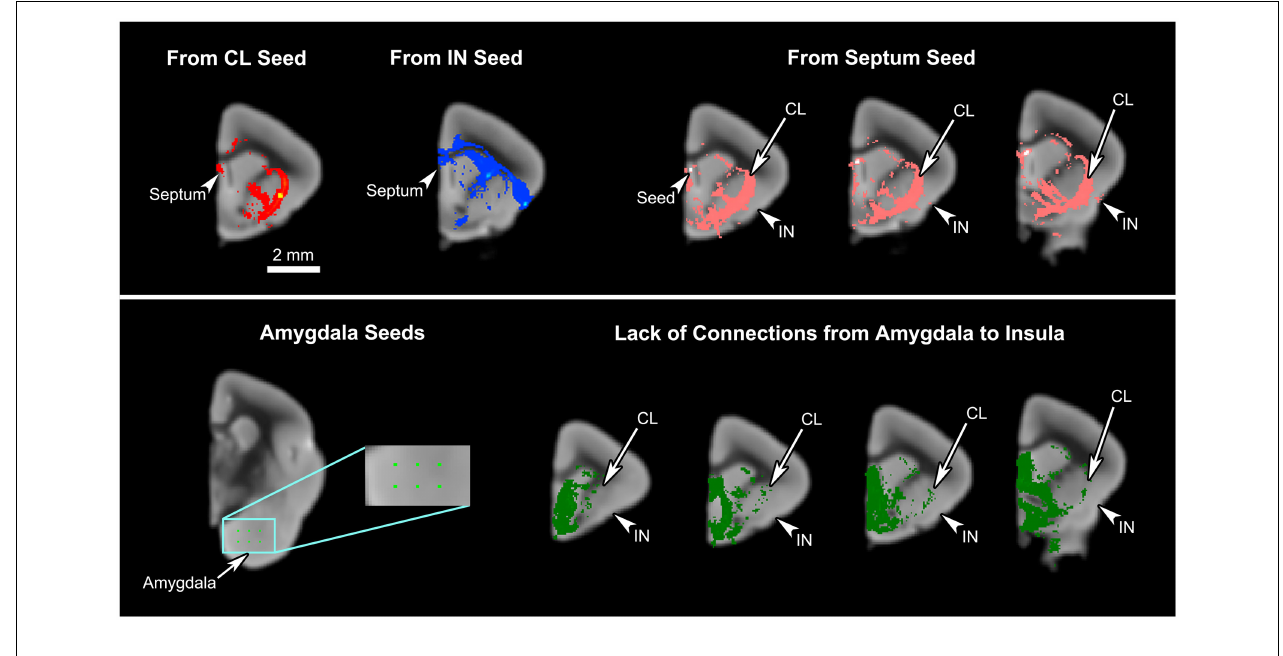
Lower panel: Six single-voxel seeds were placed in the basal part of the amygdala.The resulting tracts were pooled together and inspected for any connections to the insula.While some connections are observed in the claustrum, our data do not show any amygdalal tracts reaching the